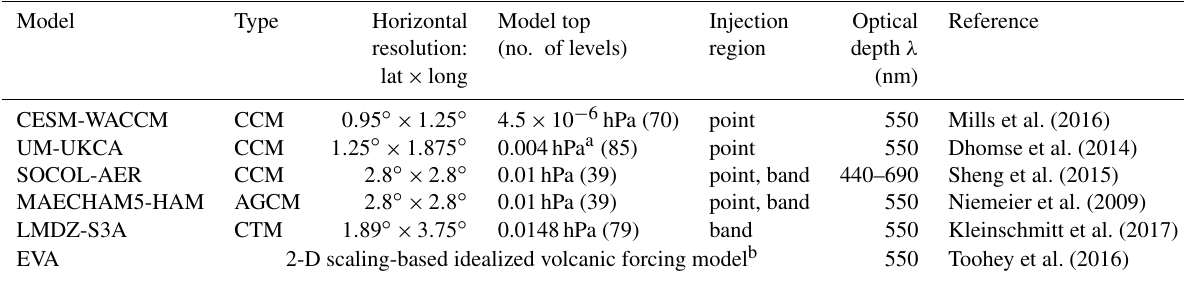
Table 1. Model overview. Model Type Horizontal Model top Injection Optical